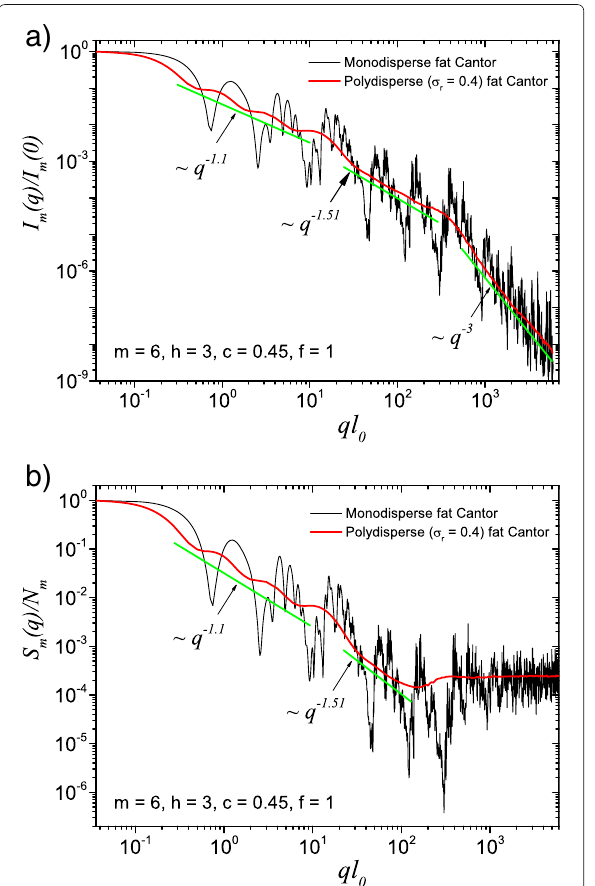
Fig. 3 (Color online) A comparison between monodisperse and polydisperse systems: a scattering intensity (Eq. (22)); b structure factor (Eq. (24)), averaged over all orientations of the fractal, according to Eq. (25). Here, f = 1, m = 6, h = 3 (i.e., the scaling factor is kept constant for three consecutive iterations), and the basic shape is a square of initial edge length l 0 = l in . For both cases, the polydispersity smears out monodisperse scattering curves, and the fractal dimensions can be recovered at each structural level